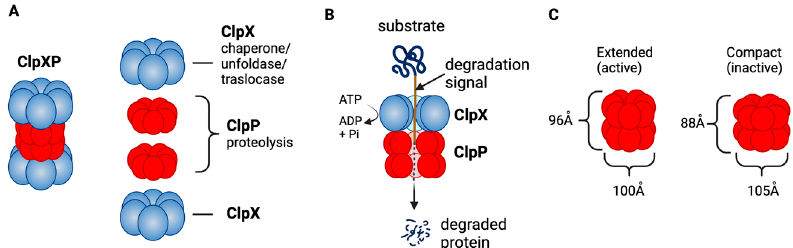
Figure 4. ClpXP structure and function as a mitochondrial protease. ( A ) ClpXP consists of ClpX (ATPase) and ClpP. ( B ) ClpX recognizes degrons of target protein, unfolds the proteins and threads them into ClpP for degradation. ( C ) Extended (active) and compact structure (inactive) of Staphylococcus aureus ClpP [243] . This figure was generated by BioRender.com (19 January 2023).